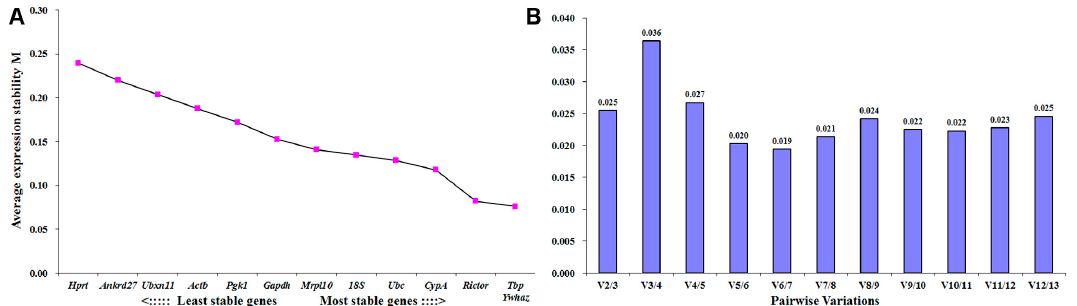
Figure 3. geNorm determined expression stability of candidate housekeeping genes in dorsal root ganglion (DRG) samples. ( A ) Average expression stability (M) values of tested housekeeping genes. The lower M value, the higher the gene stability; ( B ) The determination of the optimal number